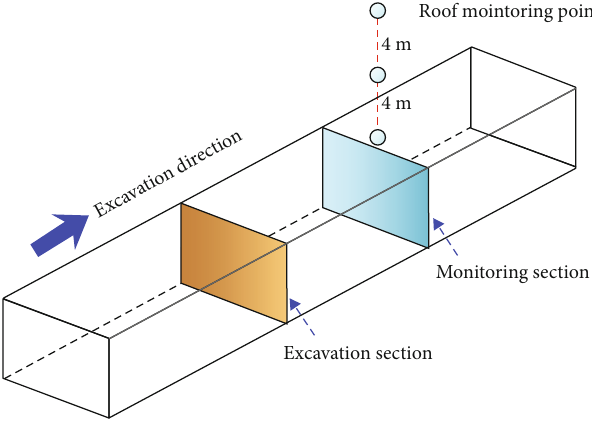
Figure 4: Locations of stress monitoring